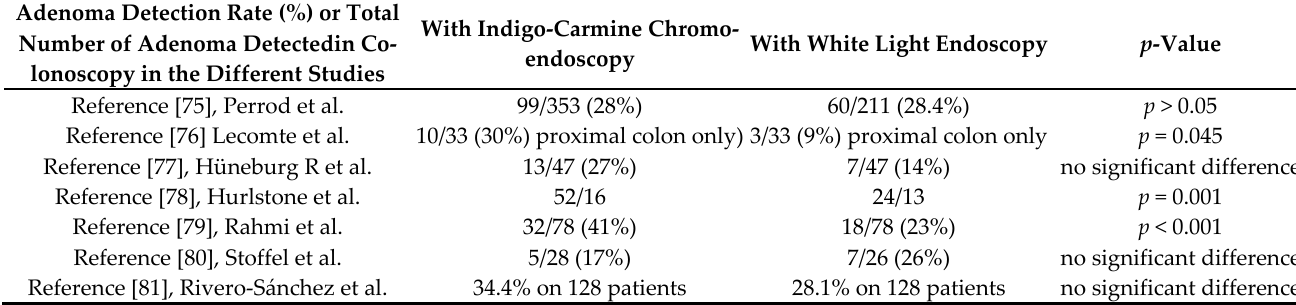
Table 4. Adenoma detection rate in the different studies with indigo-carmine chromoendoscopy or white light endos- copy.